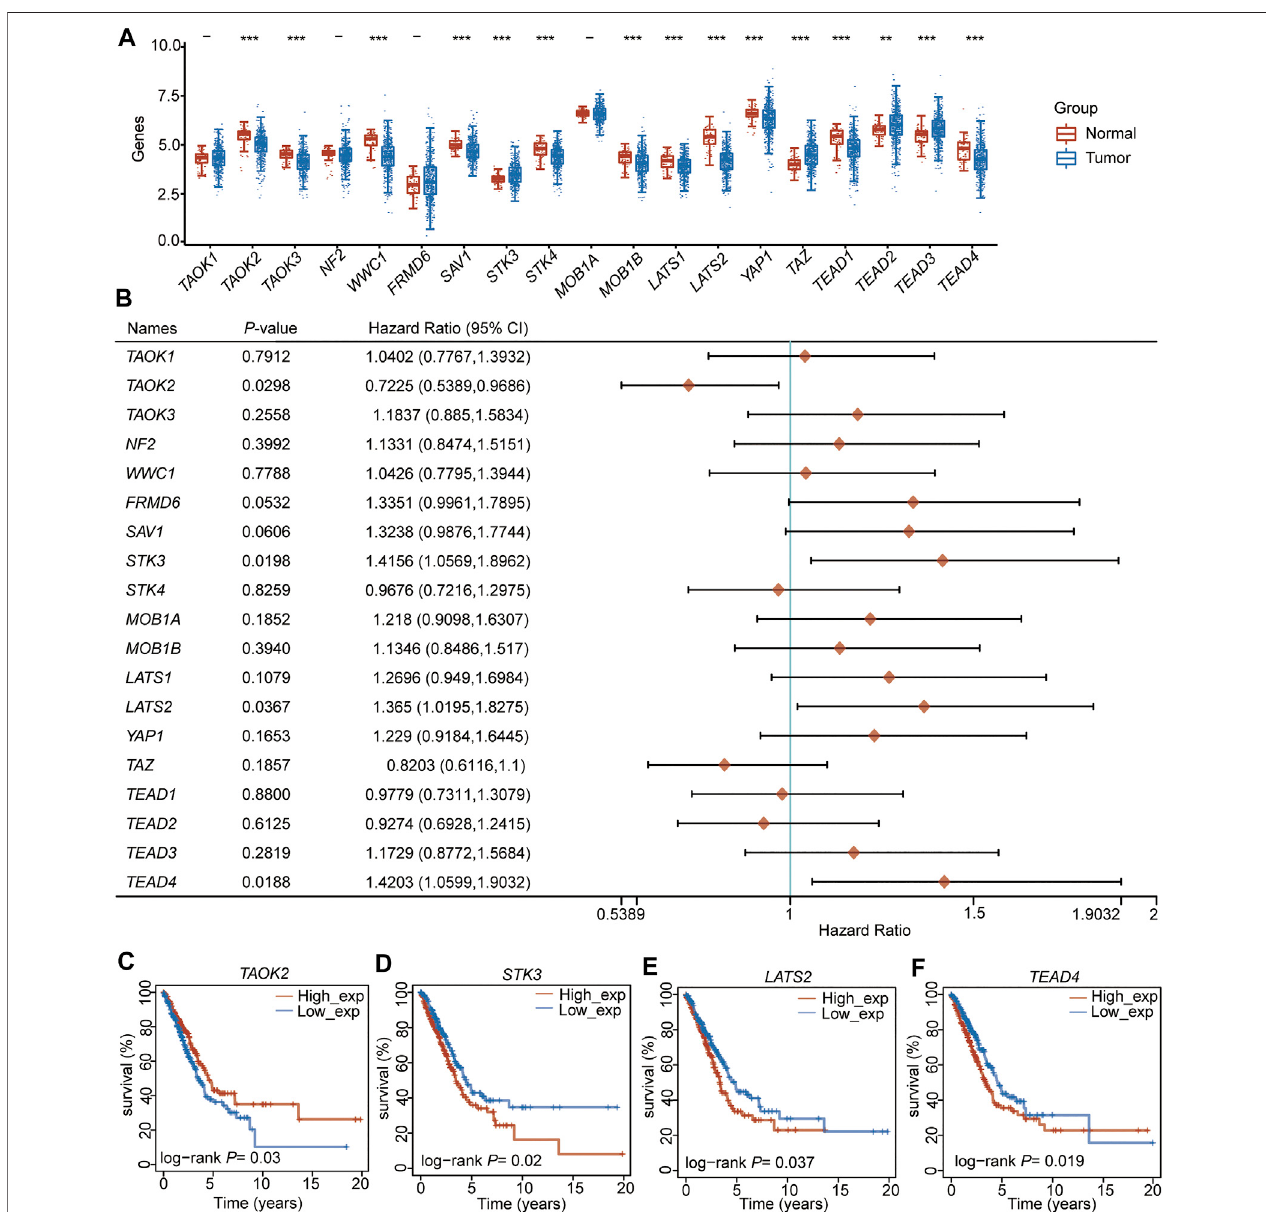
FIGURE 1 | TEAD4 is downregulated in LUAD and associated with a poor prognosis. (A) Expression level (TPM) of the Hippo pathway-related genes in LUAD compared to adjacent normal samples. (B) Forest showing the prognosis of the Hippo pathway – related genes in LUAD. (C – F) Relationship between TAOK2 (C) , STK3 (D) , LATS2 (E) , and TEAD4 (F) expressions and OS in